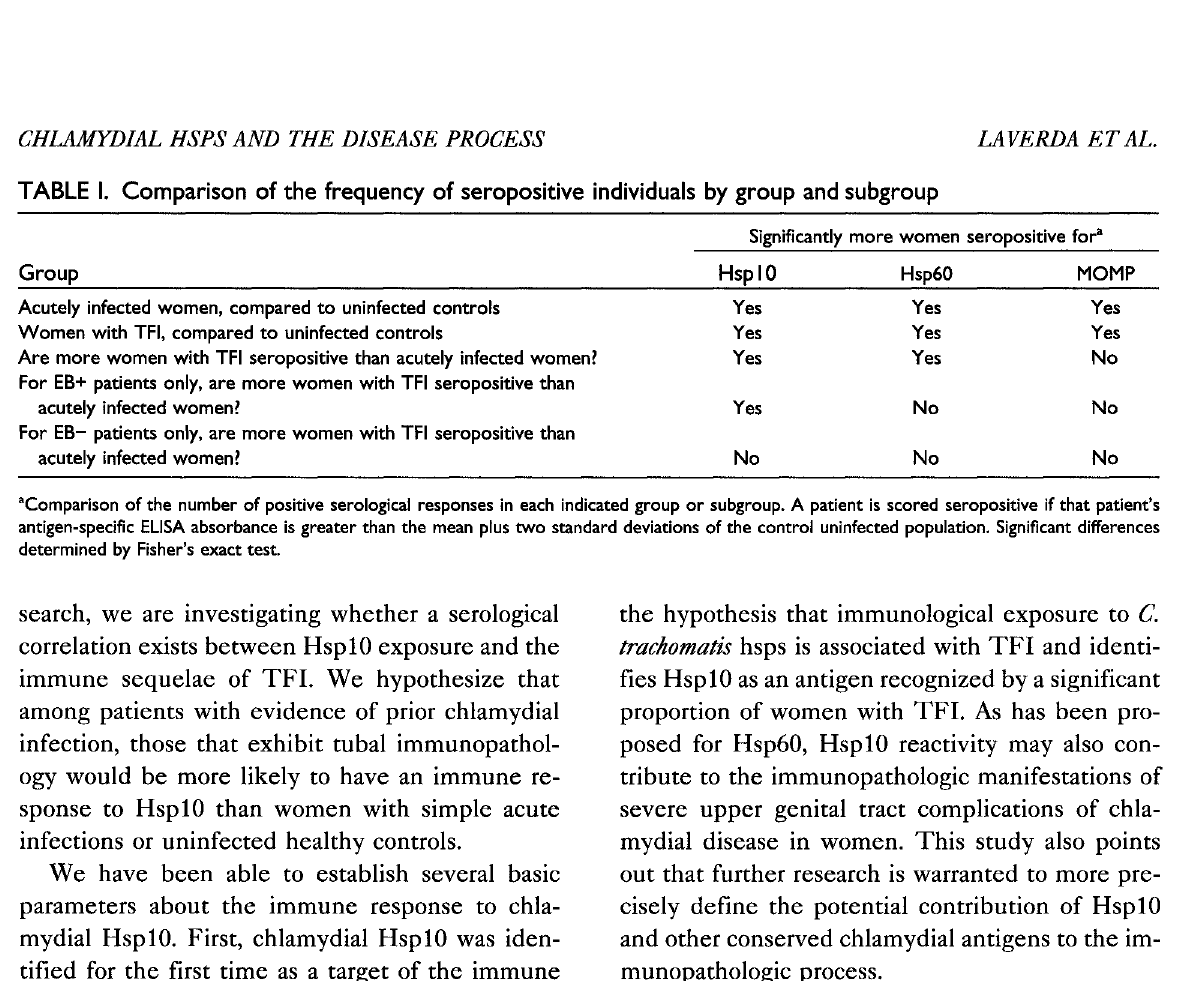
TABLE I. Comparison of the frequency of seropositive individuals by group and subgroup Group Hspl0 Hsp60 MOMP Acutely infected women, compared to uninfected controls Women with TFI, compared to uninfected controls Are more women with TFI seropositive than acutely infected women? For EB+ patients only, are more women with TFI seropositive than acutely infected women? For EB- patients only, are more women with TFI seropositive than acutely infected women? aComparison of the number of positive serological responses in each indicated group or subgroup. A patient is scored seropositive if that patient’s antigen-specific ELISA absorbance is greater than the mean plus two standard deviations of the control uninfected population. Significant differences determined by Fisher’s exact